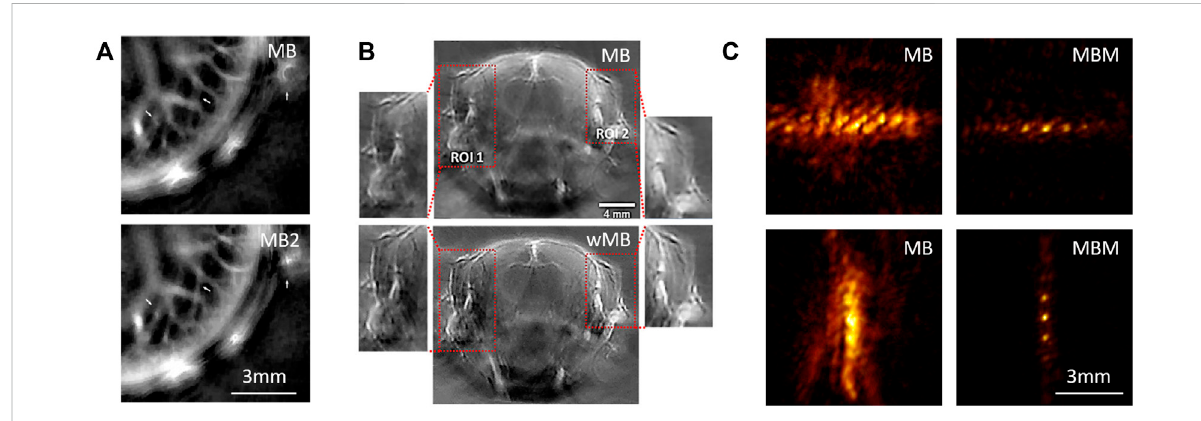
FIGURE 5 Accounting for acoustic heterogeneities in the sample. (A) Comparison of the cross-sectional optoacoustic (OA) images of the mouse liver reconstructed with a model-based (MB) algorithm considering a uniform speed of sound (top) and a MB algorithm considering a different speed of sound within the mouse and the water coupling medium (MB2, bottom). Adapted from [129] with permission from Society for Industrial and Applied Mathematics. (B) Comparison ofthecross-sectional OAimagesof themouse brainreconstructed with astandard MBalgorithm (top) and aMB algorithm weighted with the probability the collected signals are distorted by scattering or re fl ection events (wMB, bottom). Reprinted from [138] with permission from Wiley Online Library. (C) Transcranial OA images reconstructed with a standard MB algorithm (left) and with a MB algorithm built from a reference signal based on the OA memory effect (MBM, right) [142].